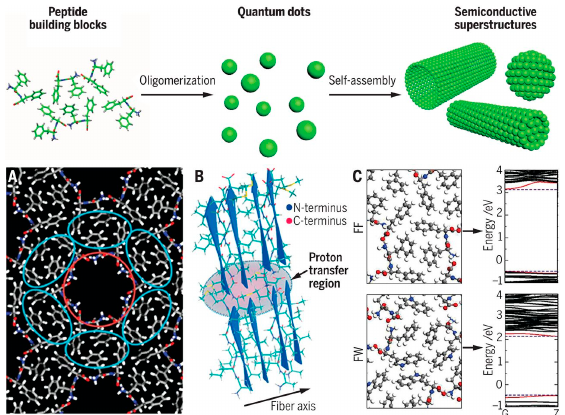
Figure 23. ( top ) Examples of peptide self-assembling architectures: peptide building blocks oligomerize to form quantum dots, themselves serving as building blocks which self-assemble into supramolecular structures with semiconducting properties. Reproduced from [99]. Copyright 2017, the American Association for the Advancement of Science. ( Bottom ) Molecular mechanisms underlying short peptide self-assembling semiconductors. ( A ) Model showing diphenylalanine (FF) nanotubular crystals acting as quantum confined structures comprising a tubular backbone (red circle) surrounded by six FF units (cyan circle). Adapted from [100]. Copyright 2014 American Chemical Society. ( B ) Cross-sectionnal view of two adjacent peptide β -sheets. The grayed area points out a quantum confined region. Adapted from [101]. Copyright 2016 American Chemical Society. ( C ) Quantum confined crystals of FF and phenylalanine-tryptophan (FW), and their respective conduction and valence band. FW shows a smallerbandgap(theconductionbandislowered). Adaptedfrom[102].